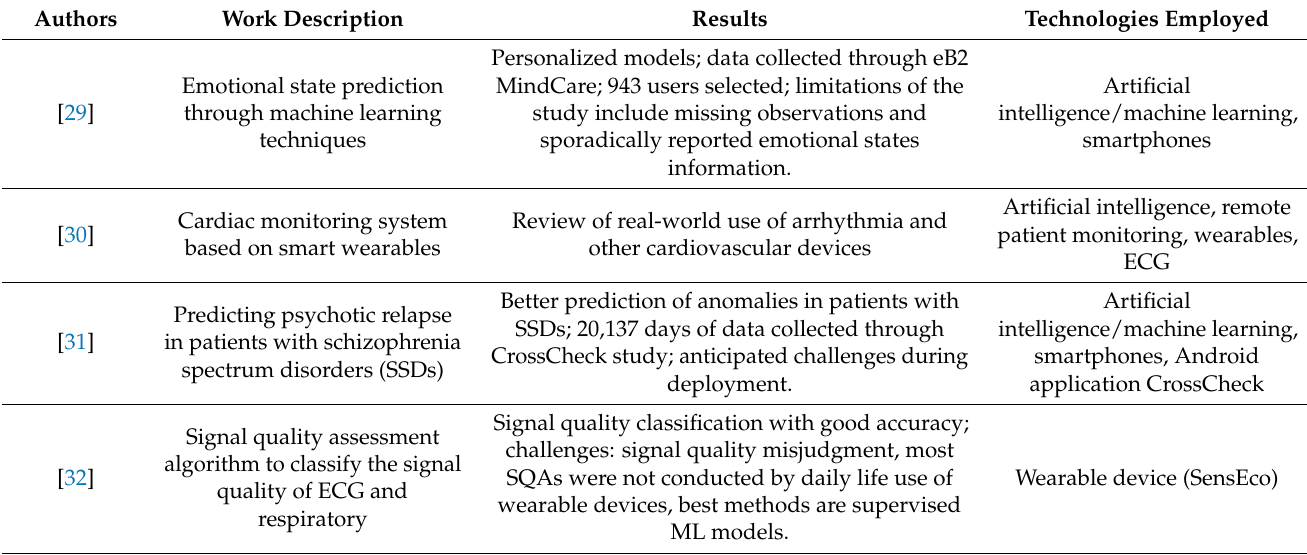
Table 2. mHealth